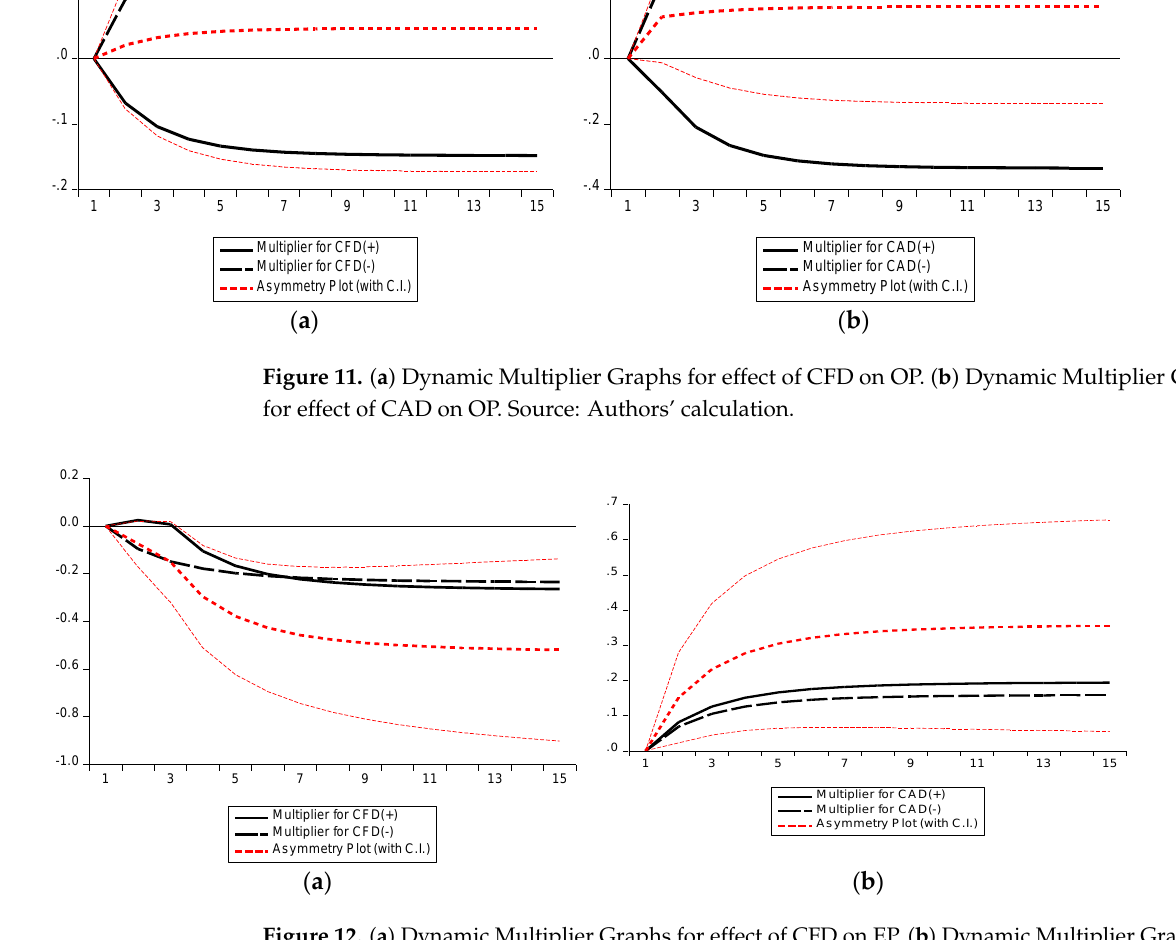
Multiplier for CFD(+) Asymmetry Plot (with C.I.) Multiplier for CFD(-) Asymmetry Plot (with C.I.) Figure 12. ( a ) Dynamic Multiplier Graphs for effect of CFD on EP. ( b ) Dynamic Multiplier Graphs for effect of CAD on EP. Source: Authors’ calculation.